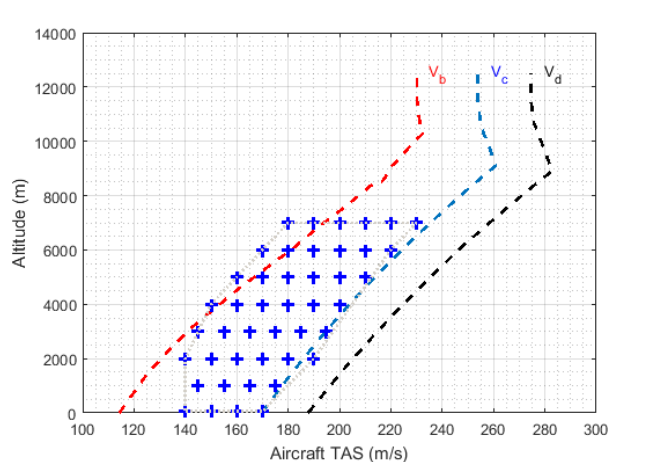
Figure 7. Full mission profile with critical test cases (orange) during “Take-off and Climb” and “Descent and Landing”.